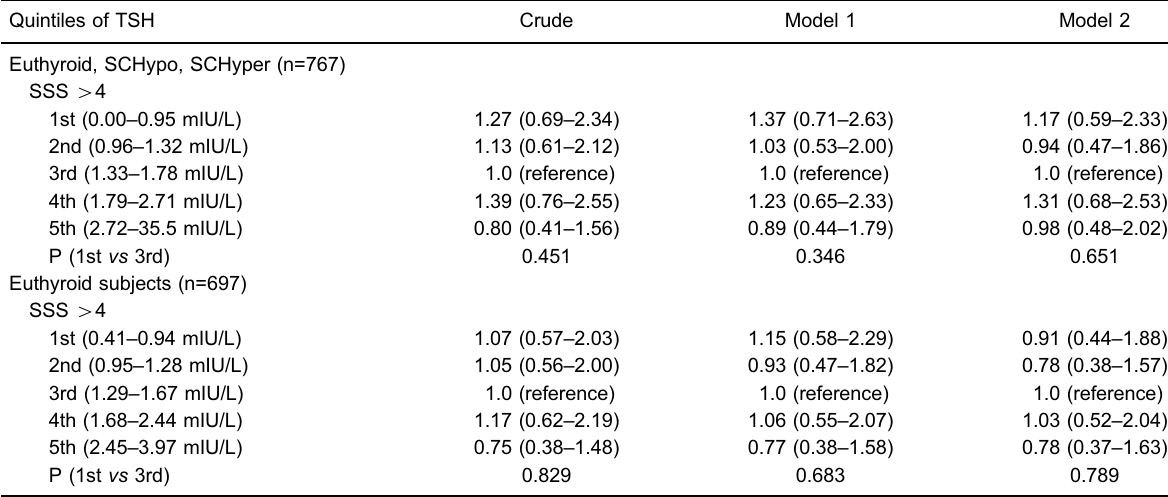
Table 4. Odds ratio and 95% con fi dence interval of association of SSS 4 4 and quintiles of TSH